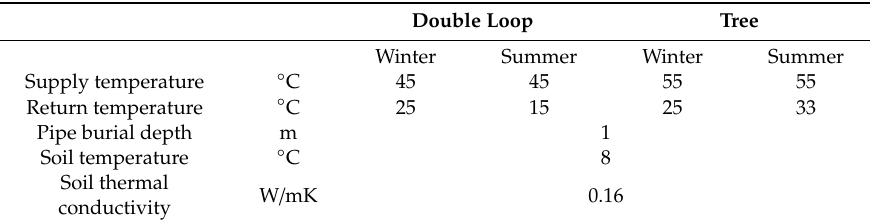
Table 5. Design parameters for the pipe